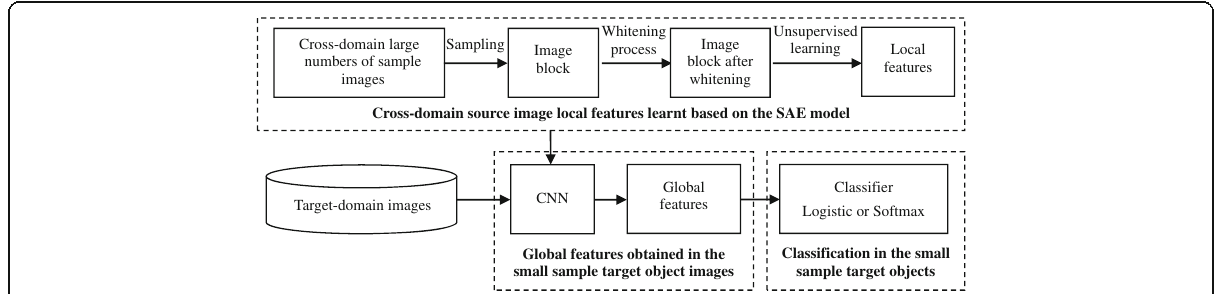
Fig. 1 Design frame diagram of small sample target object classification